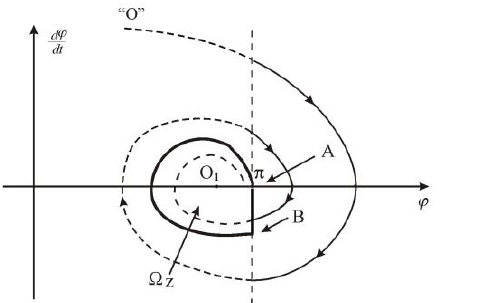
Fig. 4. Phase portraits in the PLL with additional processes with increasing instantaneous frequency detuning.